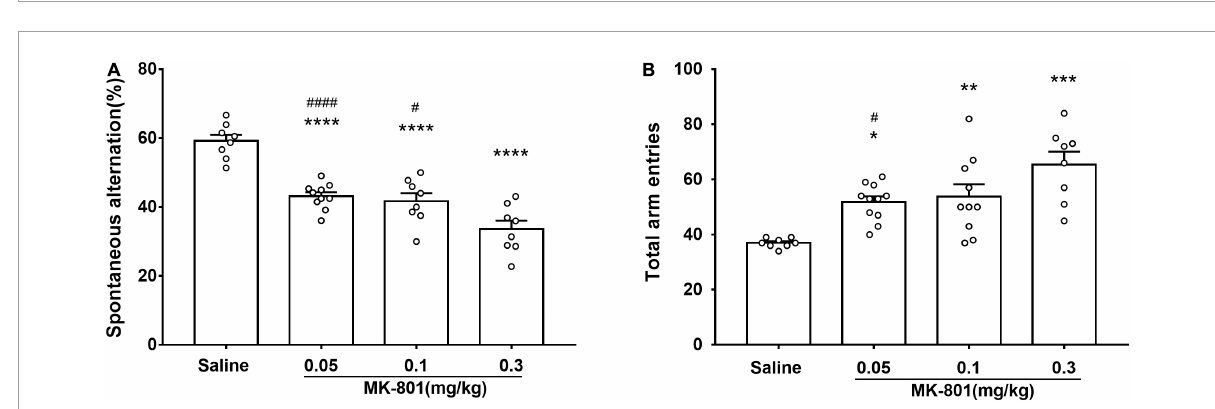
FIGURE3 MK-801 administration resulted in declined spatial working memory of mice in Y-maze. Behavioral testing started following 30 min MK-801 or 0.9% NaCl injection. The percentage of spontaneous alternations (A) and the total number of arm entries (B) were analyzed. All values were expressed as mean ± SEM (Saline: n = 8; MK-801, 0.05 mg/kg: n = 10; 0.1 mg/kg: n = 10; 0.3 mg/kg: n = 8). * p < 0 . 05, ** p < 0 . 01, *** p < 0 . 001, **** p < 0 . 0001 vs. the saline group and # p < 0 . 05, #### p < 0 . 0001 vs. the 0.3 mg/kg group as revealed by Tukey’s multiple comparisons